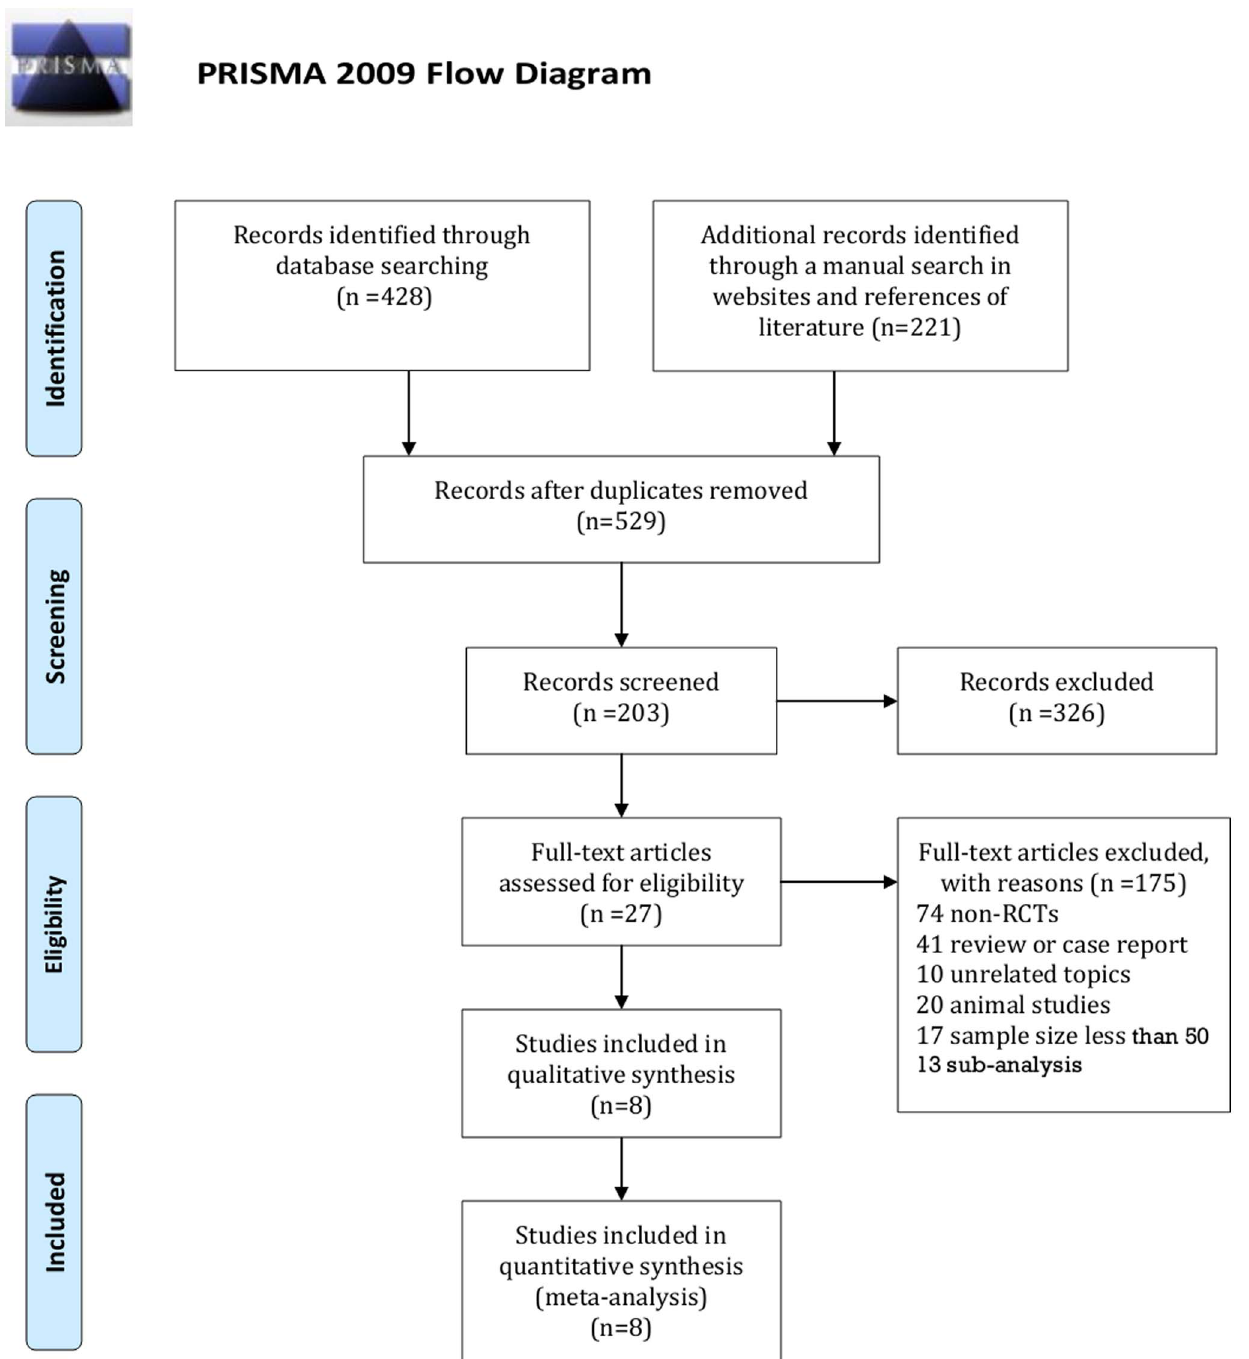
Figure 1. Flowchart for study selection.